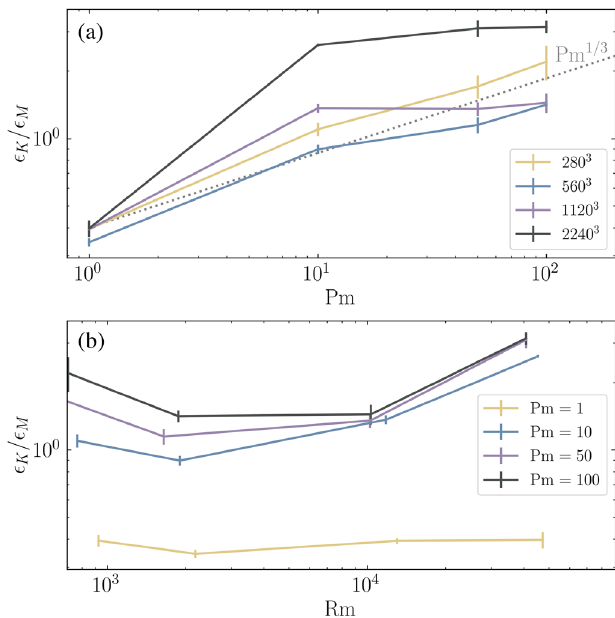
FIG. 11. Ratio of turbulent energy dissipated viscously versus resistively in the saturated state (a) versus Pm at different resolutions (and therefore different Rm) and (b) versus Rm at different Pm. Error bars reflect the standard deviation in